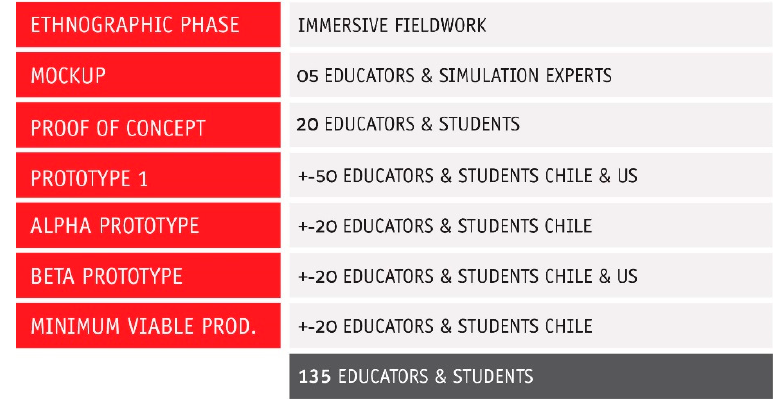
Figure 2. A general look at the process going from ethnographic data to the development of an MVP.